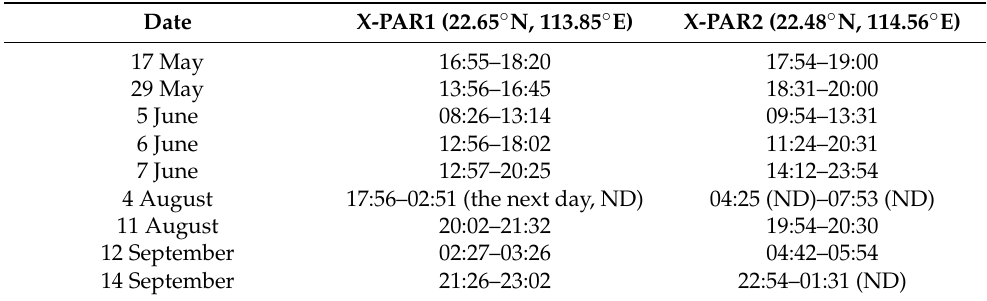
Table 2. Examples of large-scale heavy-rainfall observed by the two X-PARs in